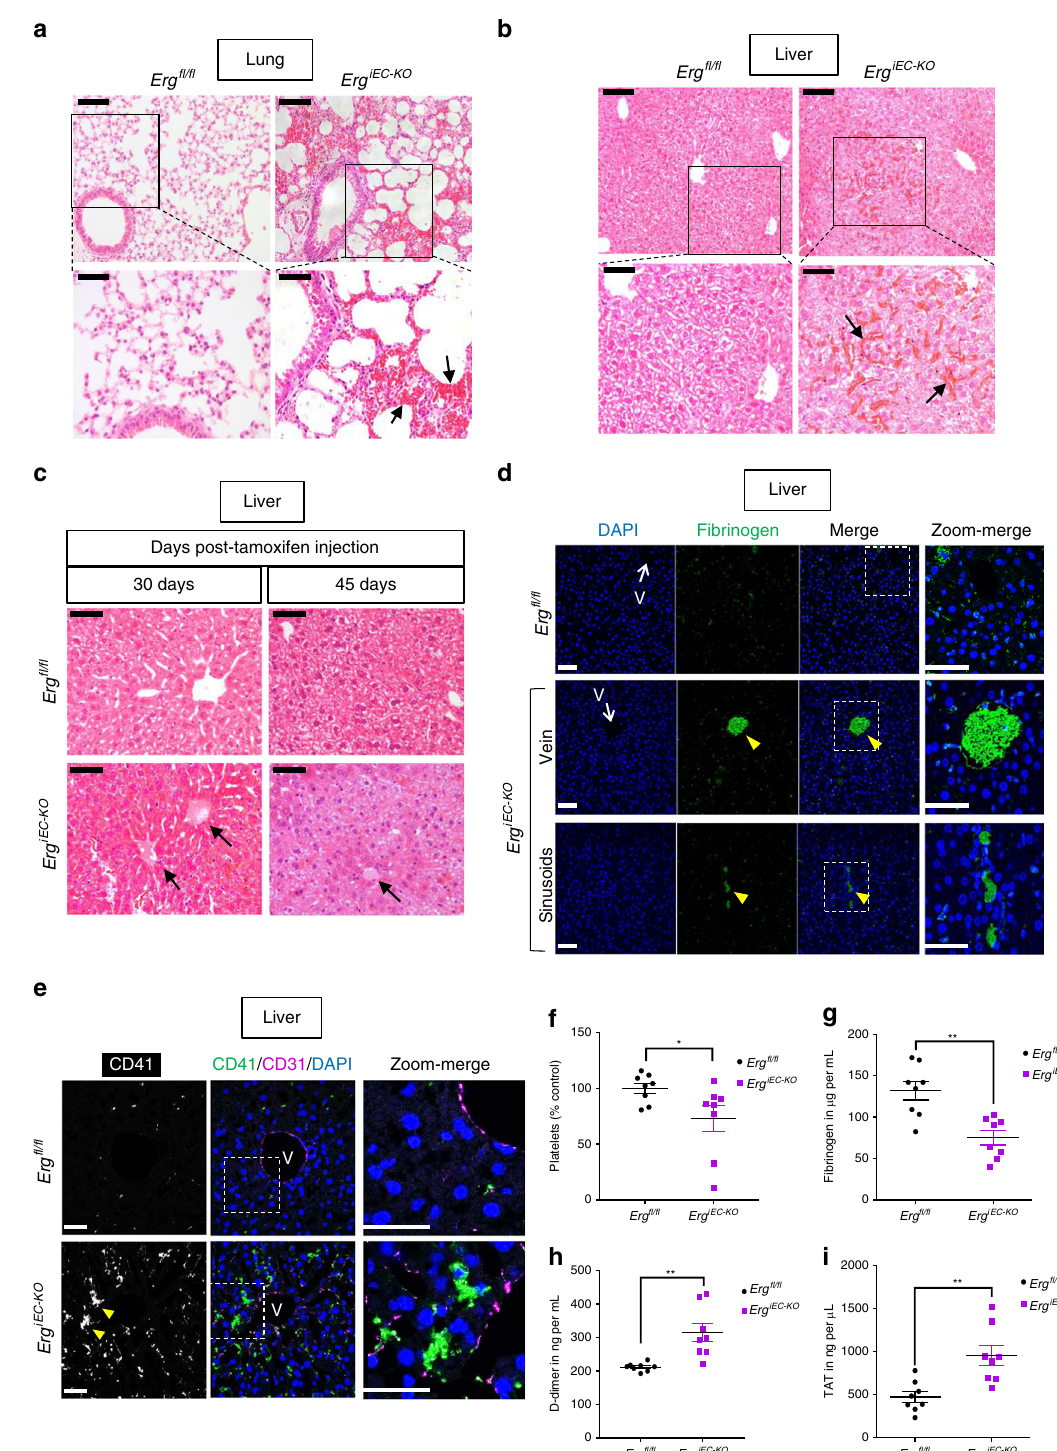
procoagulant and anticoagulant genes in a tissue-speci fi c